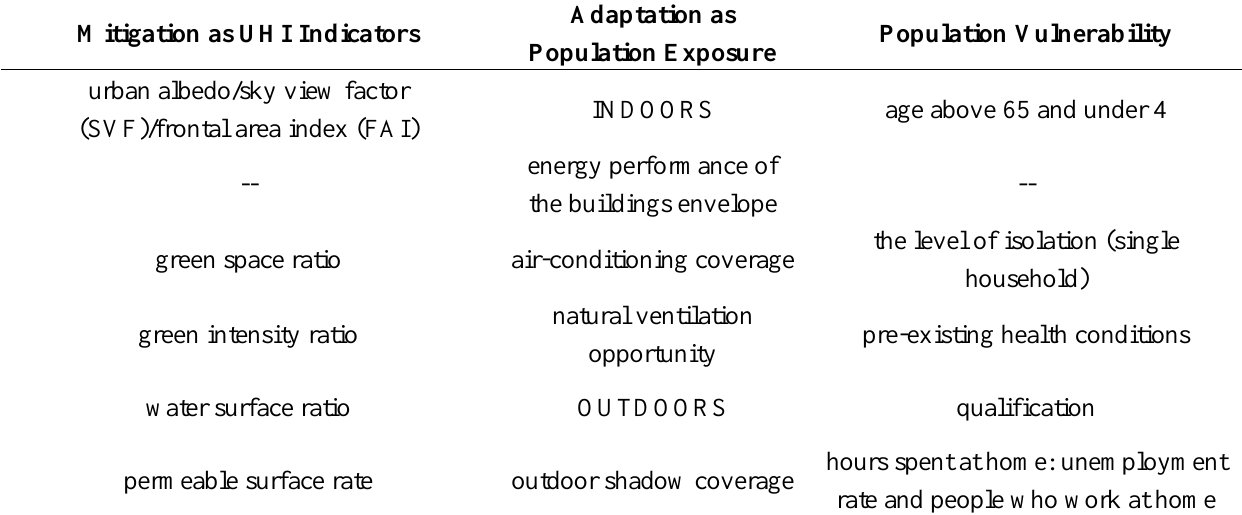
Table 1. Independent variables of precinct